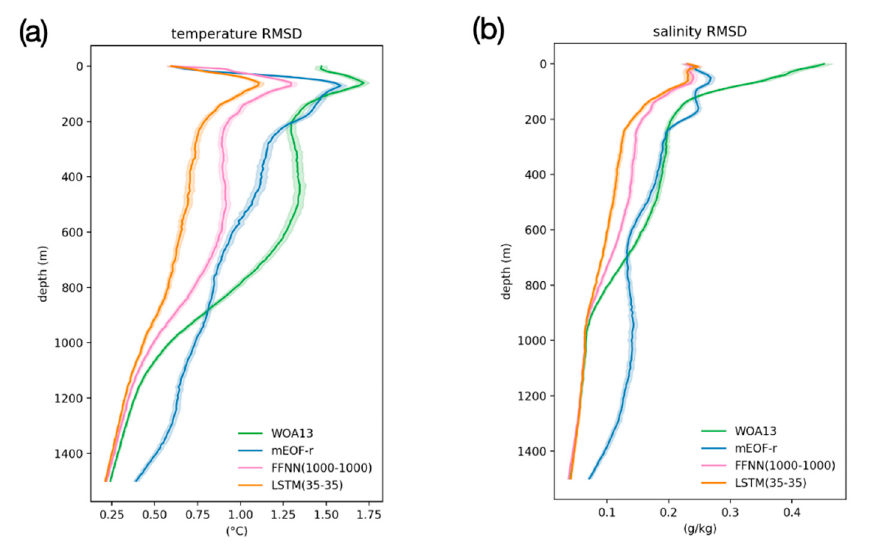
Figure 3. RMSD between temperature ( a ) and salinity ( b ) climatological and reconstructed profiles, estimated from independent test data. RMSD confidence intervals (one σ , displayed here as shadowed areas) have been estimated through a Monte Carlo approach—i.e., as the standard deviation of the statistics computed from 1000 resampling with replacement [58].